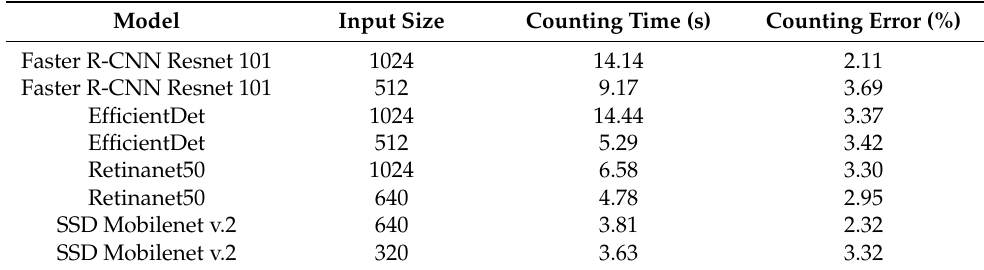
Table 4. Counting error results of the 12 × 8 cropping condition.